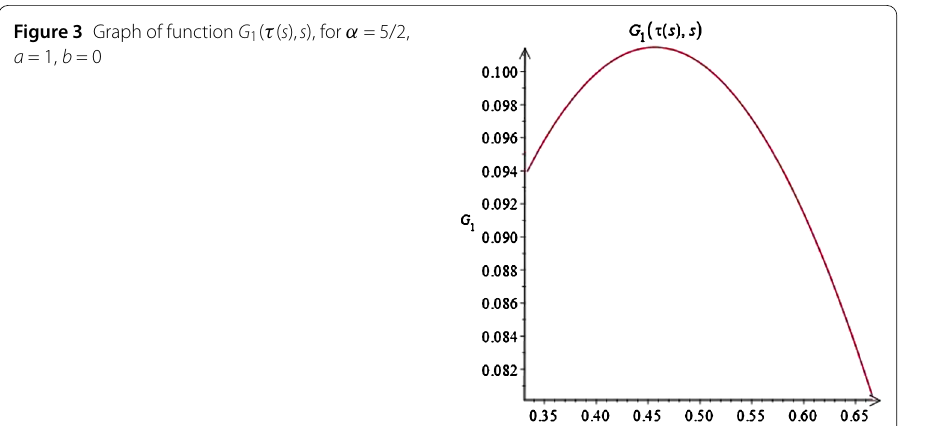
Figure 3 Graph of function G 1 ( τ ( s ), s ), for α = 5/2, a = 1, b =